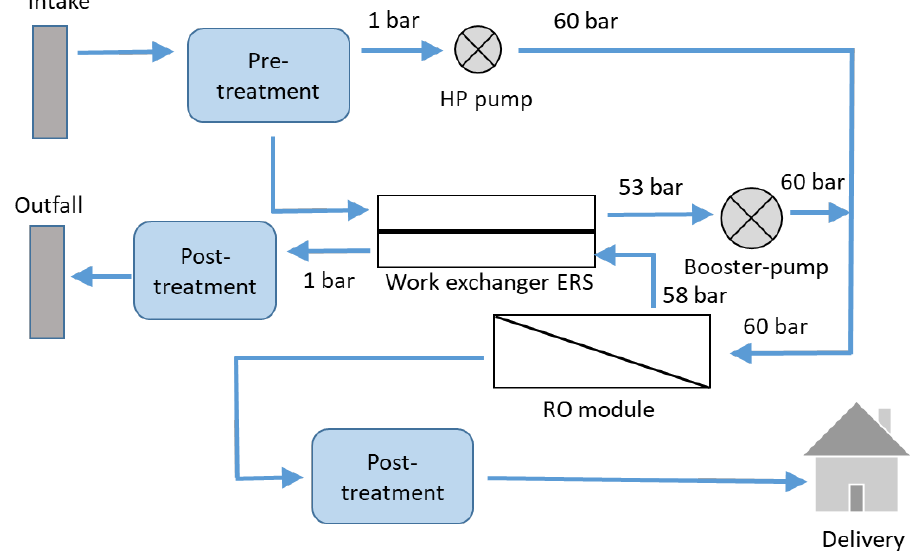
Figure 2. Simplified reverse osmosis scheme with an energy recovery system (adapted from [1]).